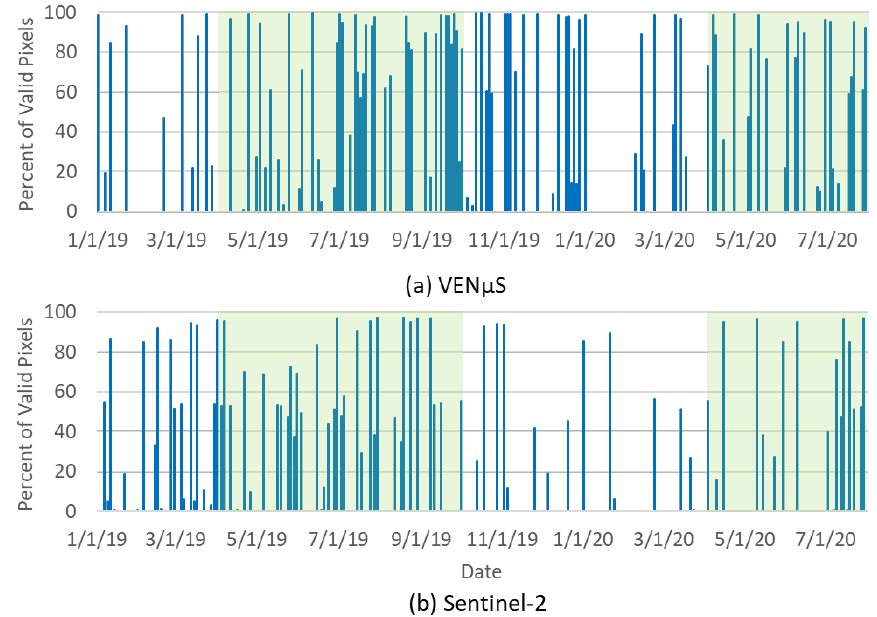
Figure 2. Percent of clear VENµS ( a ) and Sentinel-2 pixels ( b ) over BARC in 2019 and 2020. The cover crop termination periods are highlighted in light green.